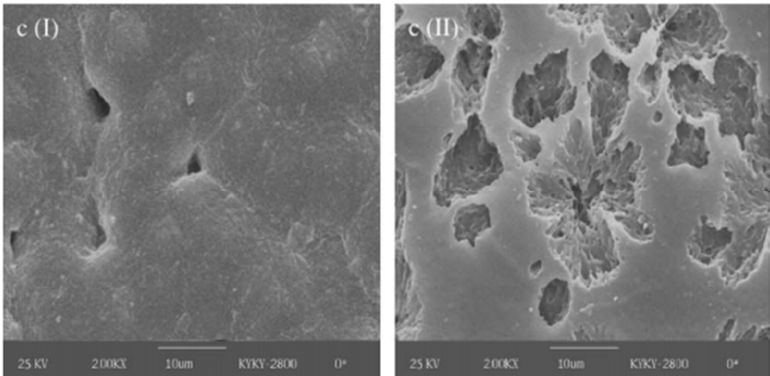
Figure 4. Surface morphology of bioplastic made with PHB (12% HHx) before (left) and after deg- radation (right)